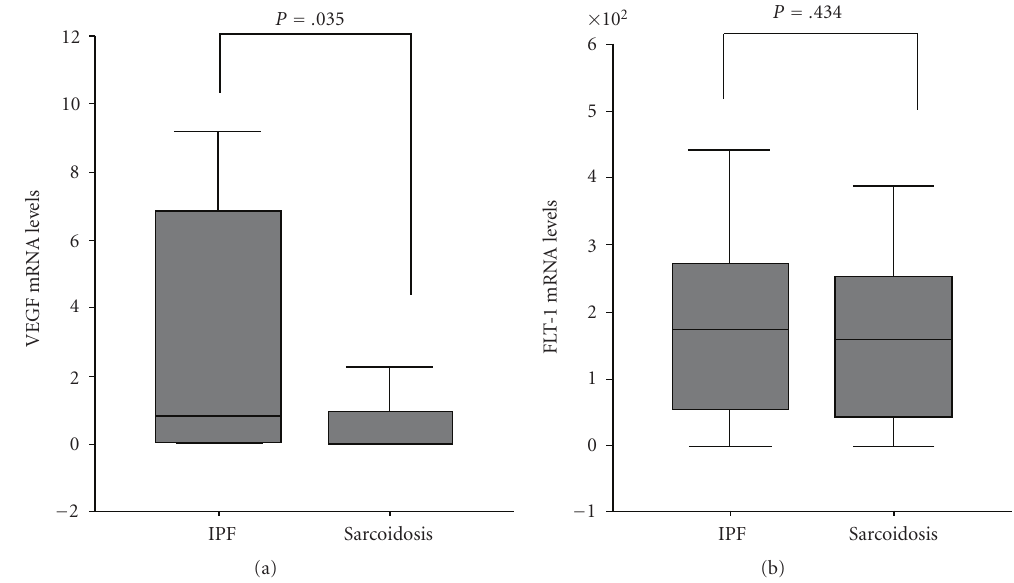
Figure 1: mRNA expression of VEGF/flt-1 in IPF versus Sarcoidosis.